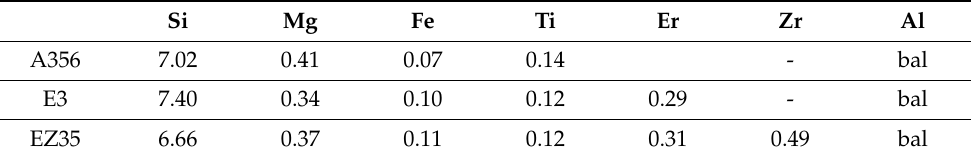
Table 1. Chemical composition (mass%) of the studied alloys. Si Mg Fe Ti Er Zr Al A356 7.02 0.41 0.07 0.14 - bal E3 7.40 0.34 0.10 0.12 0.29 - bal EZ35 6.66 0.37 0.11 0.12 0.31 0.49